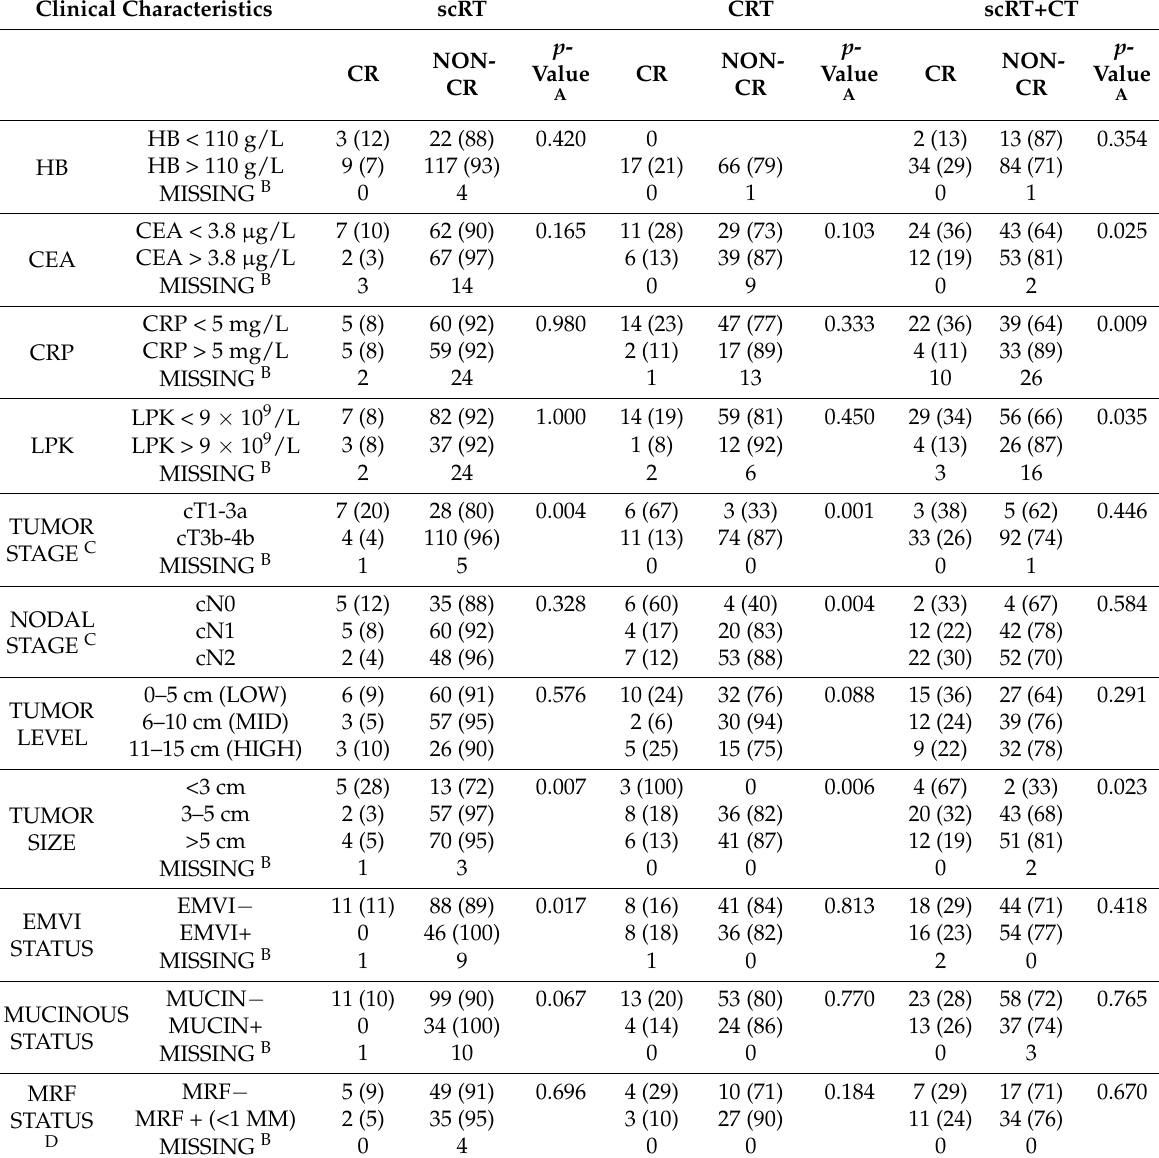
Table 2. Laboratory, clinical and MRI parameter’s association to treatment response in scRT, CRT and scRT+CT groups. Clinical